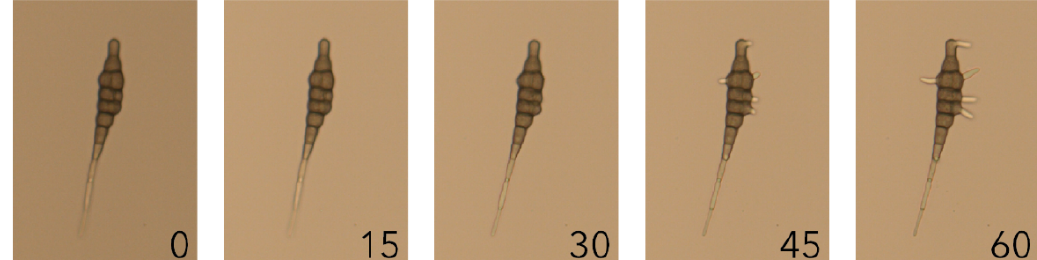
Figure 1. Germination of A. solani conidium. A. solani conidium in sterile tap watered imaged every 15 min for the first hour after harvesting. The numbers indicate minutes after harvest.